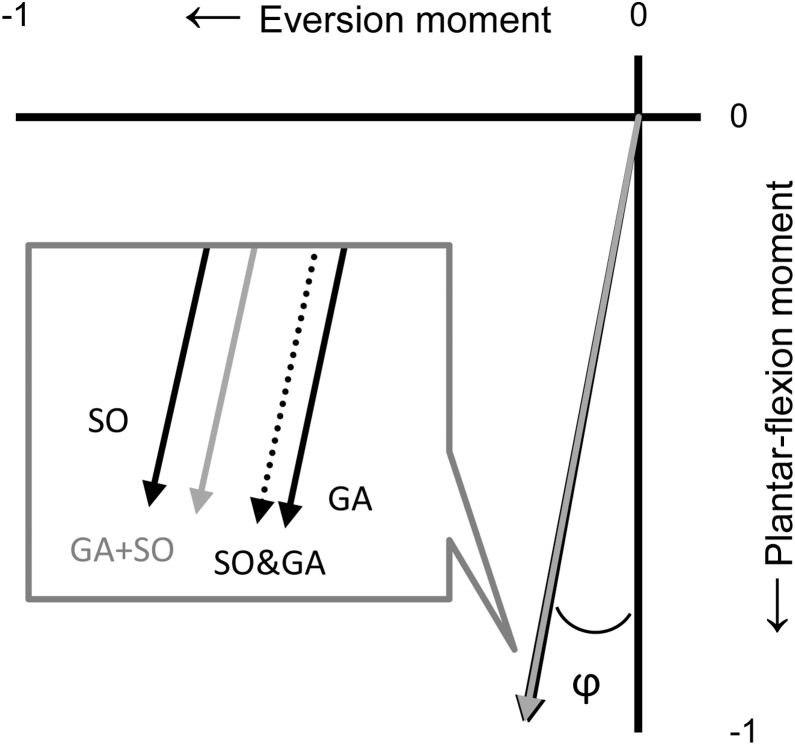
Unit vector direction of the ankle moments in the transverse plane.The unit vectors of SO (black solid line), GA (black solid line), the mathematical sum of SO&GA (black dotted line) and the simultaneously excitation of GA+SO (grey solid line) at 100° ankle angle. Knee angle was kept constant at 90°. For each vector in the transverse and frontal planes, the angle relative to the plantar-flexion moment axis was calculated (see φ), while for each vector in the sagittal plane, the angle relative to the eversion moment axis was calculated. These angles were used as a measure of the vector direction (see Fig. 6).